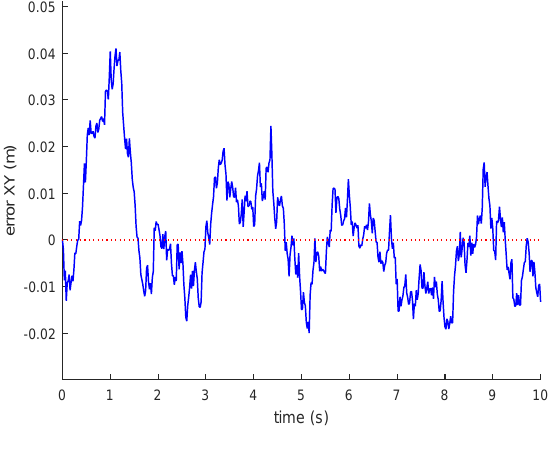
Figure 10. The tracking error.